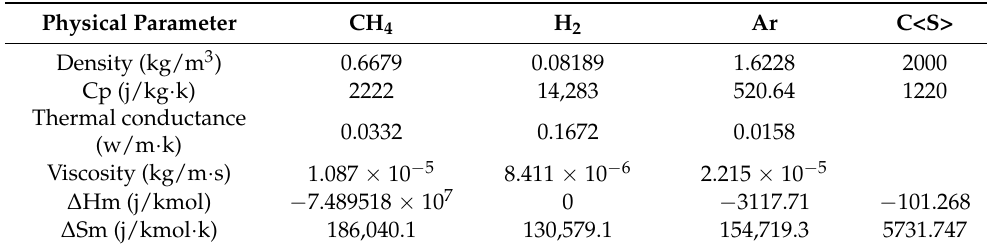
Table 2. The physical properties of various materials.